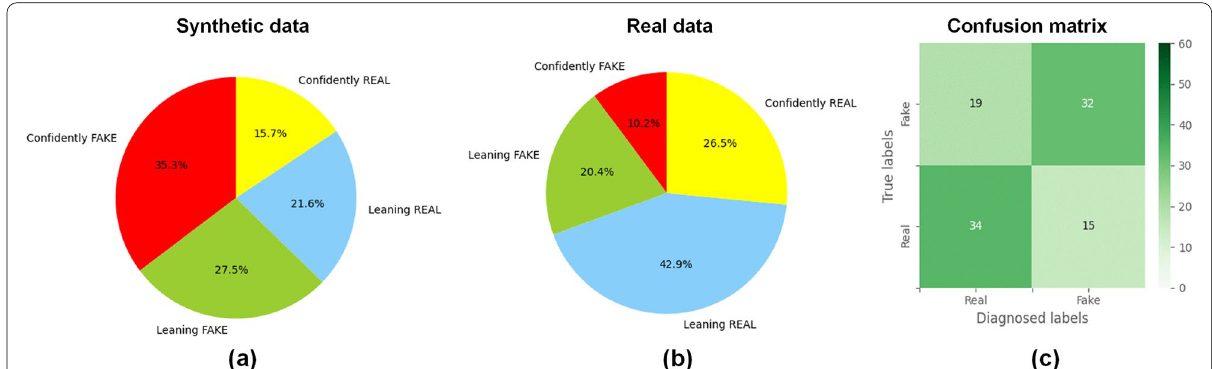
Fig. 4 Visual Turing test results. a , b Prediction distribution in synthetic and real ground glass nodules. c Confusion matrix for the